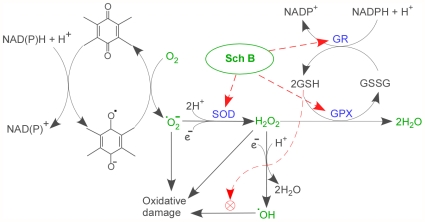
A proposed model for the protective role of Sch B in Dox-induced oxidative stress leading to cardiotoxicity.SOD, superoxide dismutase; GPX, glutathione peroxidase; GR, glutathione reductase ; •O2
—, superoxide anion; •OH, hydroxyl radical; H2O2, hydrogen peroxide; ⊗,GSH directly scavenges hydroxyl radial through the reaction: GSH+R•→GS•+RH, then GS• dimerizes to form GSSG.